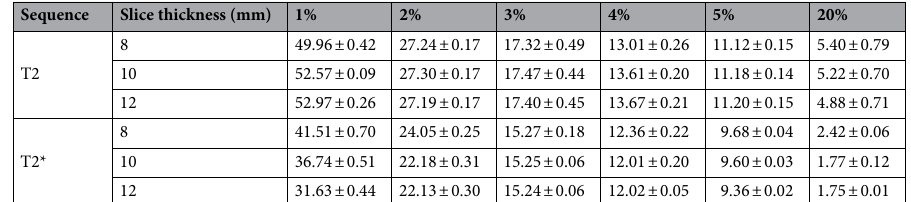
Sequence Slice thickness (mm)